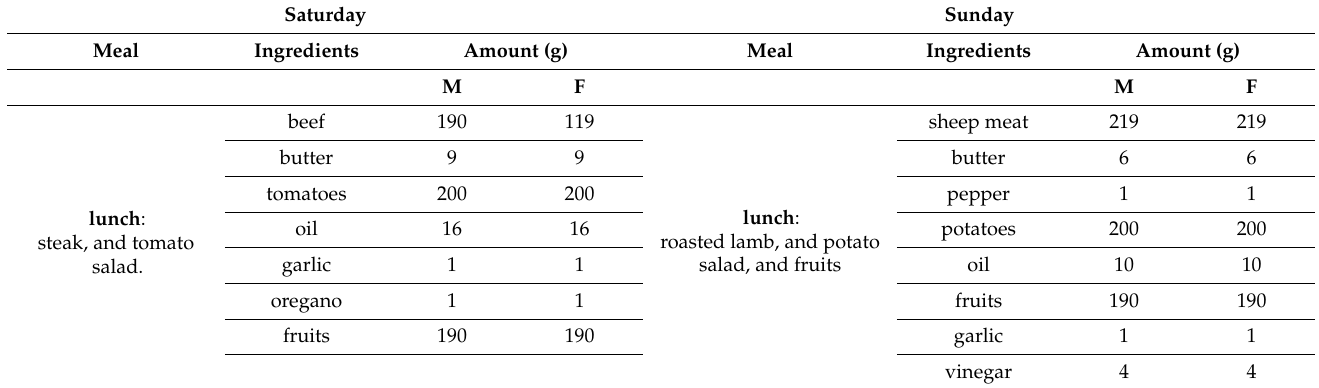
Table 10. Individual meals for 1st and 2nd class patients at lunch and dinner. Months: September and October (2)